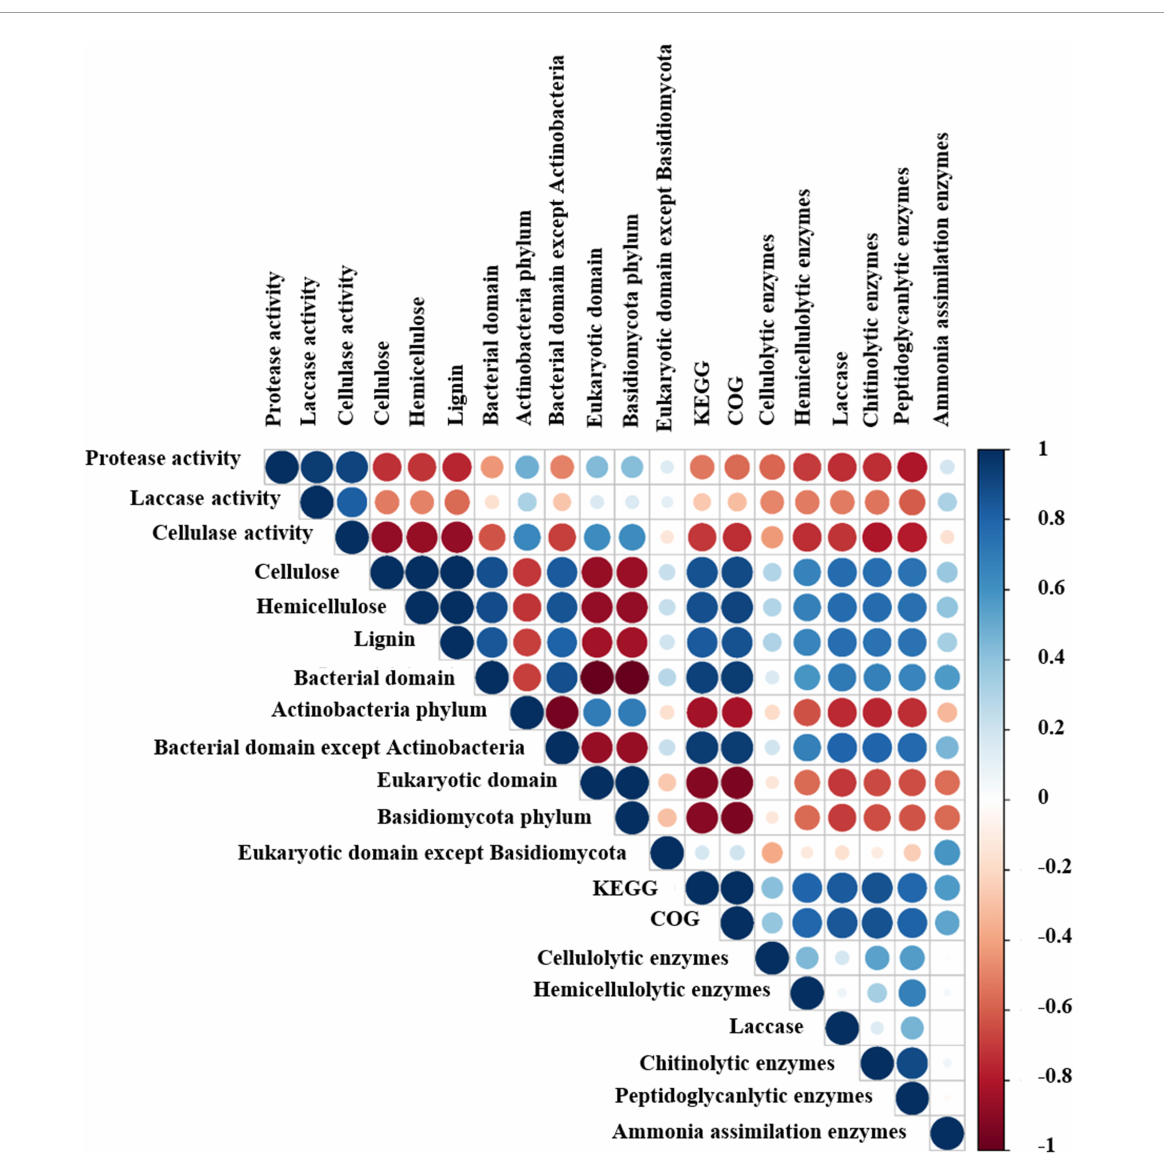
FIGURE2 Pearson correlation analysis among the relative abundance of microbial taxa, functional genes and physicochemical properties of the composting substrate at the different growth stages of oyster mushroom. Positive and negative correlations are shown in blue and red, respectively. The size of each circle indicates the value of the correlation coefficient. T1, T2, T3, T4, and T5 indicate the day on which composting was completed (day 0: before spawning), mycelial colonization (day 3), mid-incubation (day 10), end-incubation (day 20: